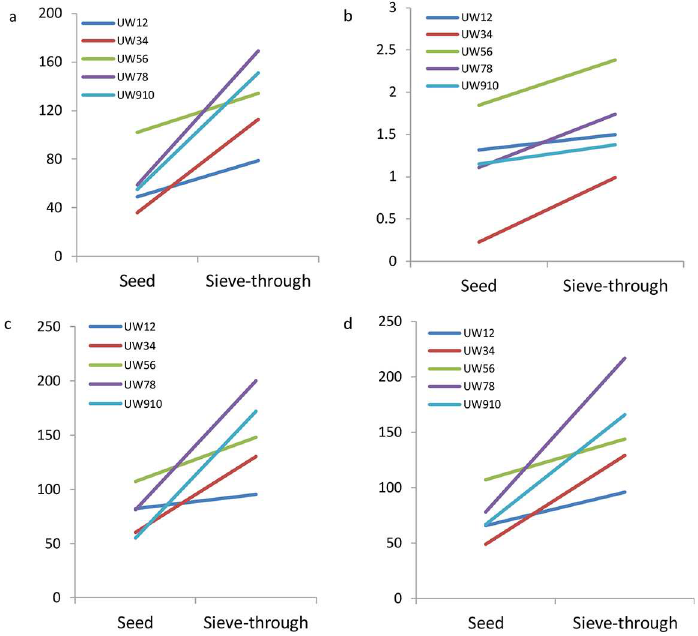
Fig 2. The pairwise comparison of the alpha diversity of seed and sieve-through of each wheat sample. a) OTU number, b) Shannonindex c) ACE Estimator and d) Chao1Estimator.